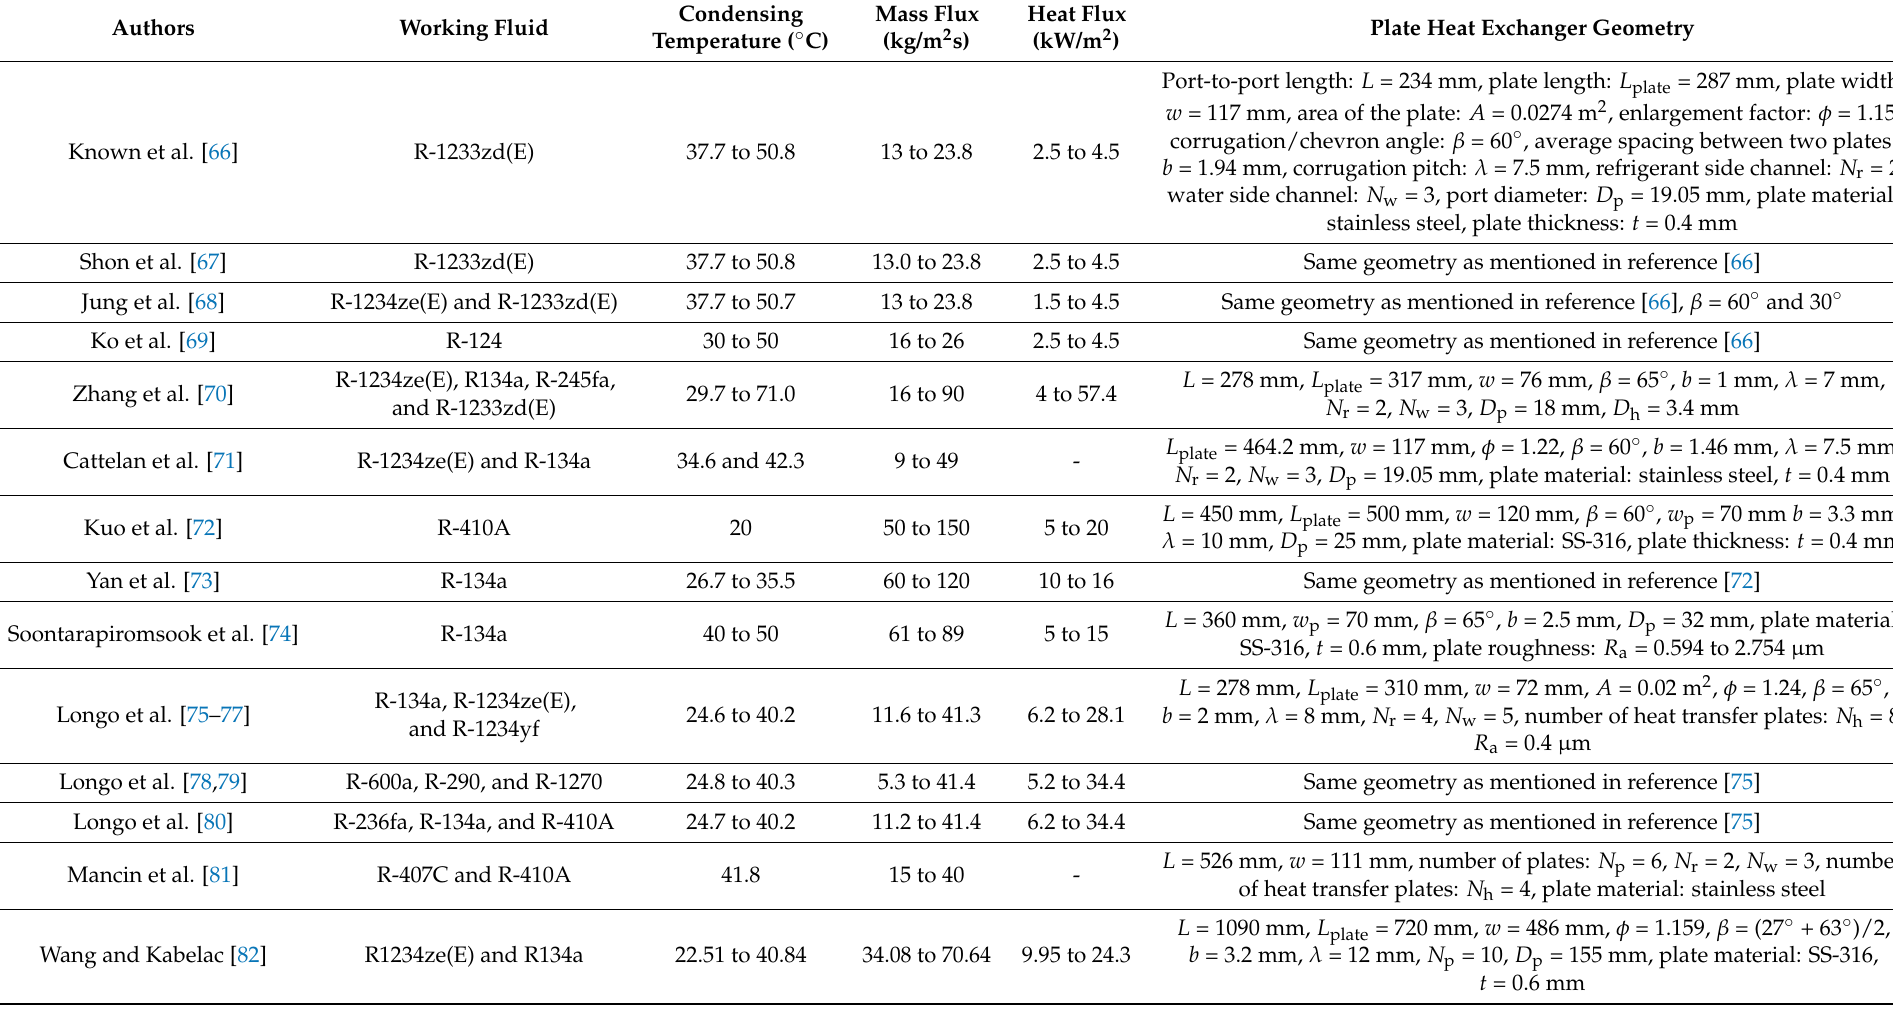
Table 4. Dimensions/specifications of the plate heat exchanger and experimental conditions reported in the